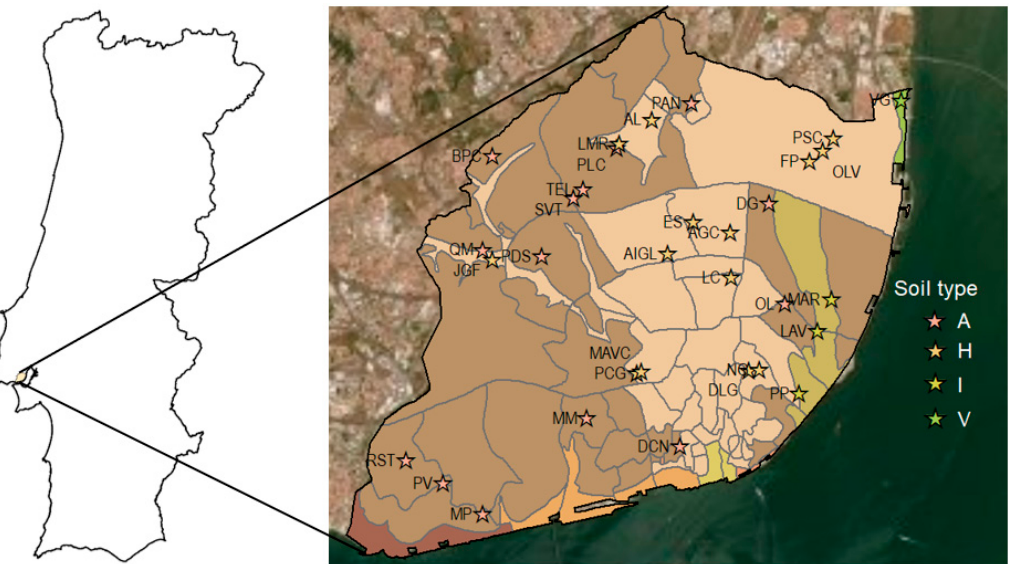
Figure 1. Identification of the CML’s 32 schools of secondary education and second and third cycles of basic education, using the Lisbon’s soil layer produced by LNEC.